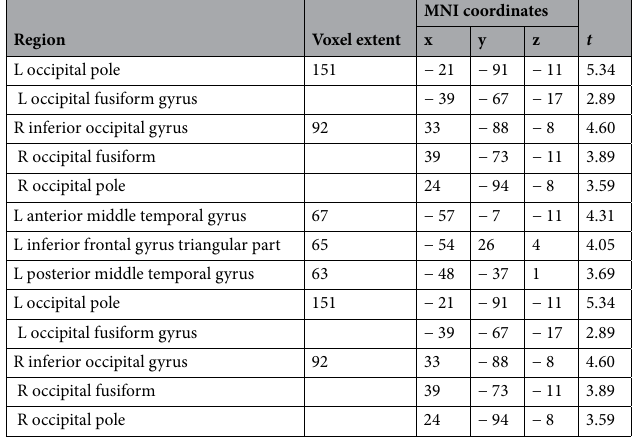
Table 2. Regions exhibiting an effect of word predictability. L left hemisphere, R right hemisphere.